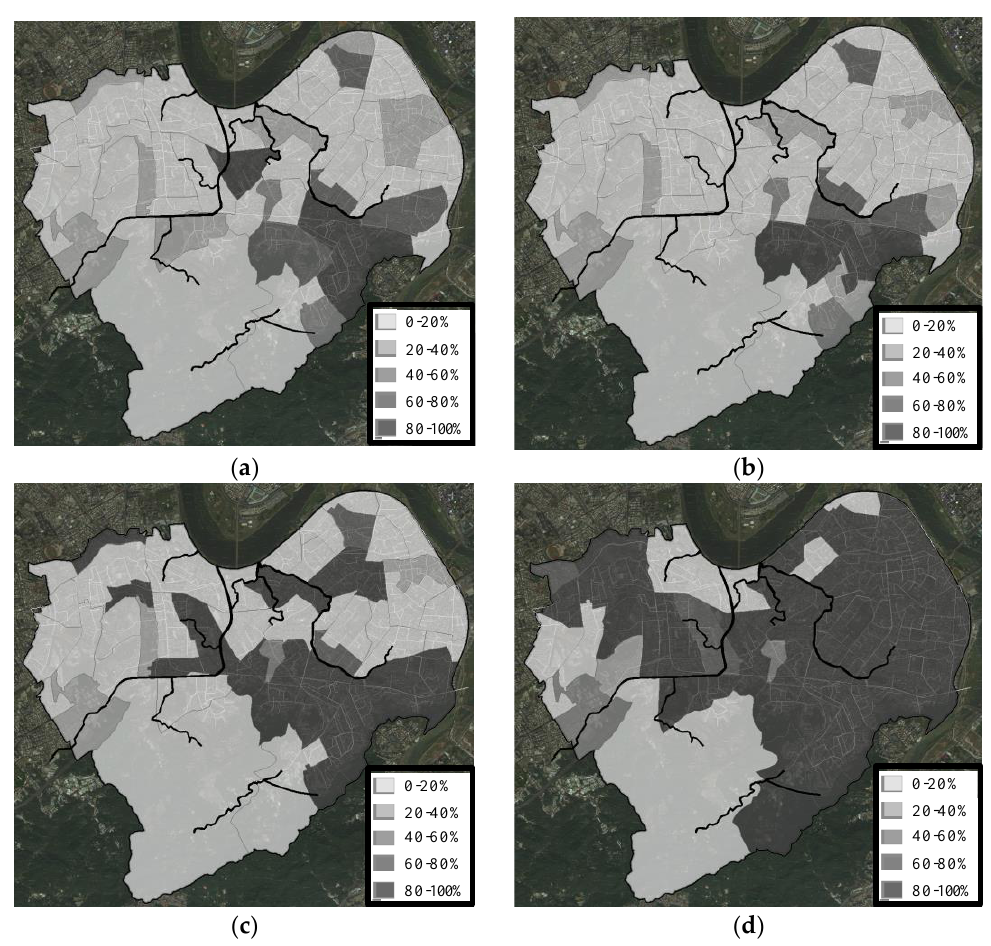
Figure 10. Optimal LID spatial distribution for the flood peak reduction under different LID costs: ( a ) 30% cost, ( b ) 40% cost, ( c ) 50% cost, and ( d ) 80% cost.